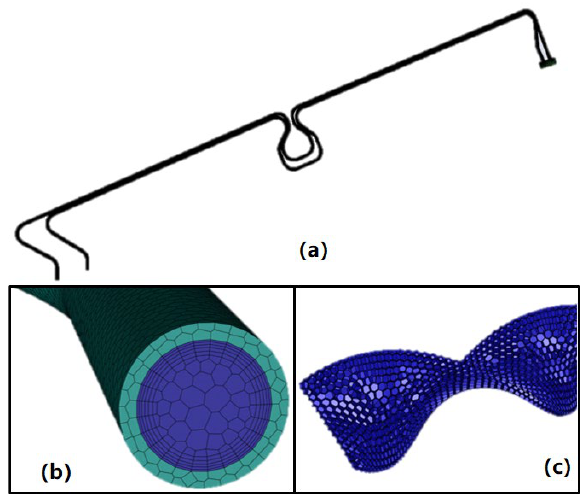
Figure 5. Grid of the swirl tube model: ( a ) main body; ( b ) inlet section; and ( c ) part of swirl tape section.